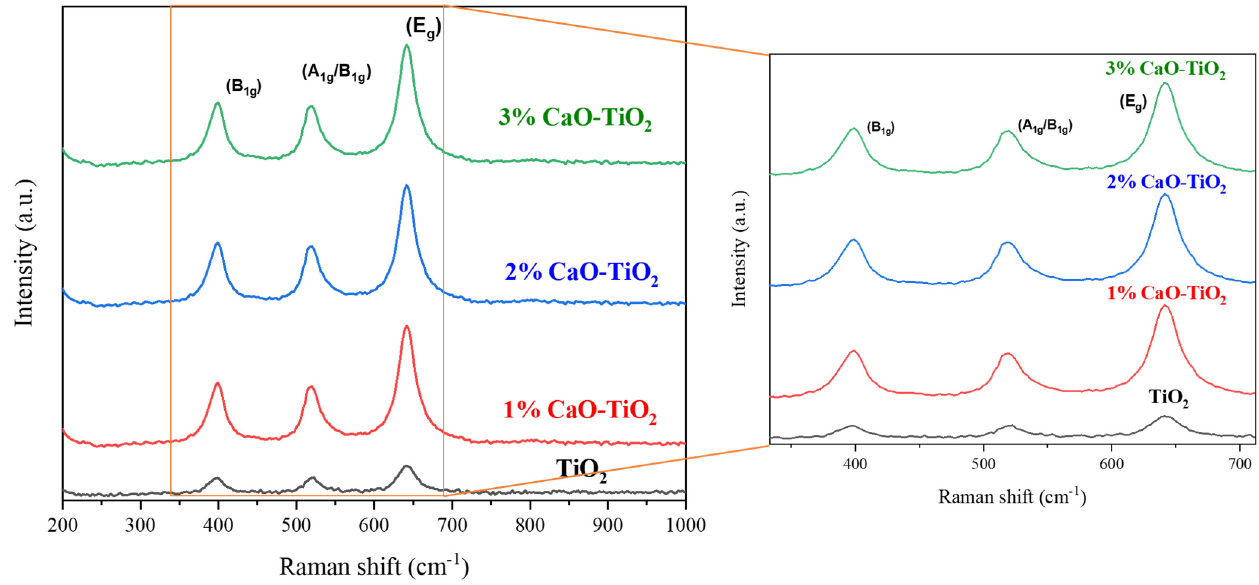
Figure 2. Raman spectroscopy of pure TiO 2 and 1–3% CaO loaded TiO 2 . FTIR spectra of undoped and CaO doped titania is presented in Figure 3a–d. The spectrum is in the range of 600 and 4000 cm − 1 . In Figure 3a, the peaks at 3200–3600 cm − 1 are due to OH bonds. In Figure 3c, the intensity of peak around 1200 cm − 1 and around 2200 cm − 1 is increased due to the addition of CaO content into the titania lattice. From Figure 3b–d, the intensity of these situated peaks reduces by increasing the amount of the CaO. In Figure 3c, bending vibration is up to a maximum, which is then again reduced when doped with 3% CaO loaded TiO 2 , as shown in Figure 3d. This supports the assump- tion that 2% loading is an optimized loading. There are some broad peaks at ~ 3600 cm –1 then 3100 cm –1 indicating the presence of a hydroxyl group, while peaks around 1630 cm − 1 are found to be corresponding to the bending vibration of H-O-H [64]. The peak near 1140 cm − 1 corresponds to the possible interaction of the Ti-O-Ca bond. In addition, varying in- tensity of vibration of the hydroxyl group with increasing doping of up to 2% CaO load- ing, and then suppression with 3% CaO loading, indicate the presence of various polari- ties on the effective doping of CaO into the titania lattice, resulting in an increased number of oxygen vacancies with increasing loading up to 2% CaO loading and decreased for 3% CaO loaded TiO 2 [65]. Overall, all the grown catalysts follow the same pattern and indicate 2% CaO loading is an optimized loading and confirm the successful synthesis of desired catalysts as observed in XRD analysis.